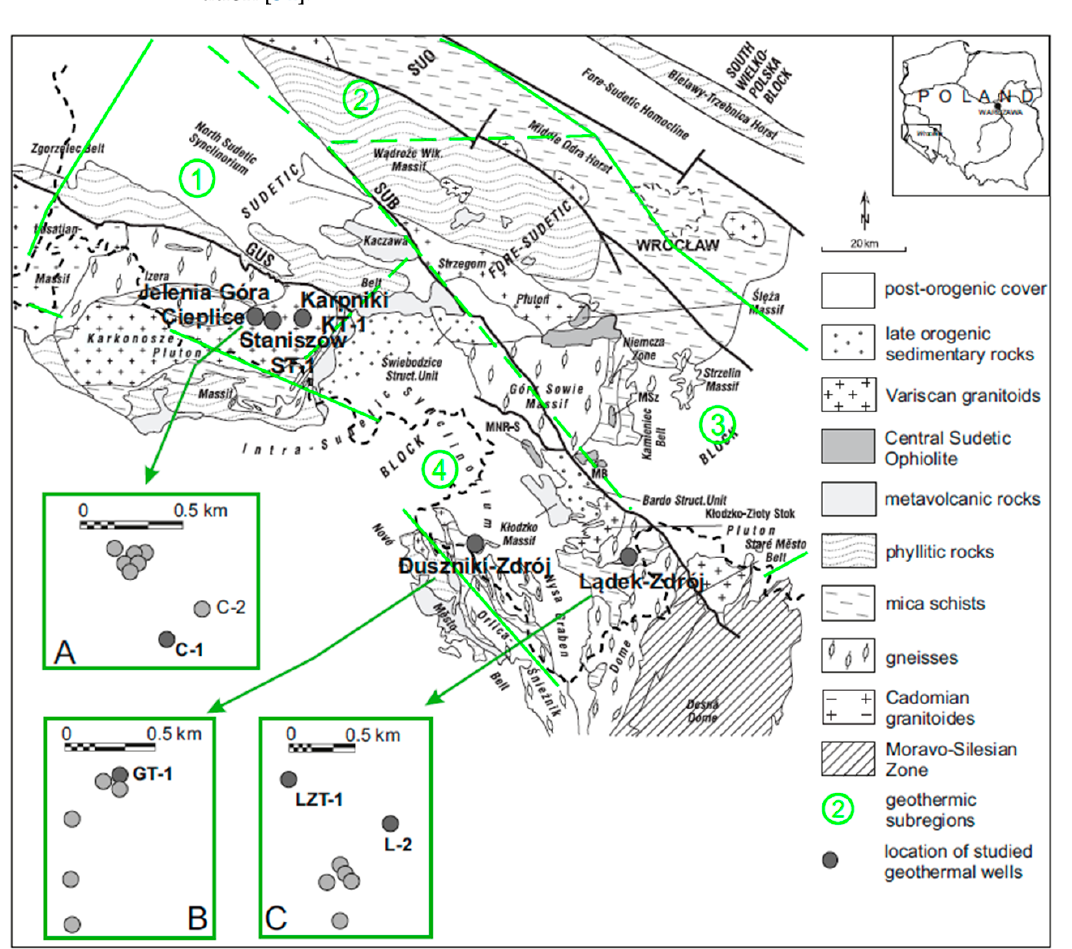
Figure 1. Location of deep wells capturing thermal waters in the Lower-Silesian block (based on [25,40,41]). Abbreviations: GUS—main intra-Sudetic fault; MB—Braszowice–Brze ź nica massif;